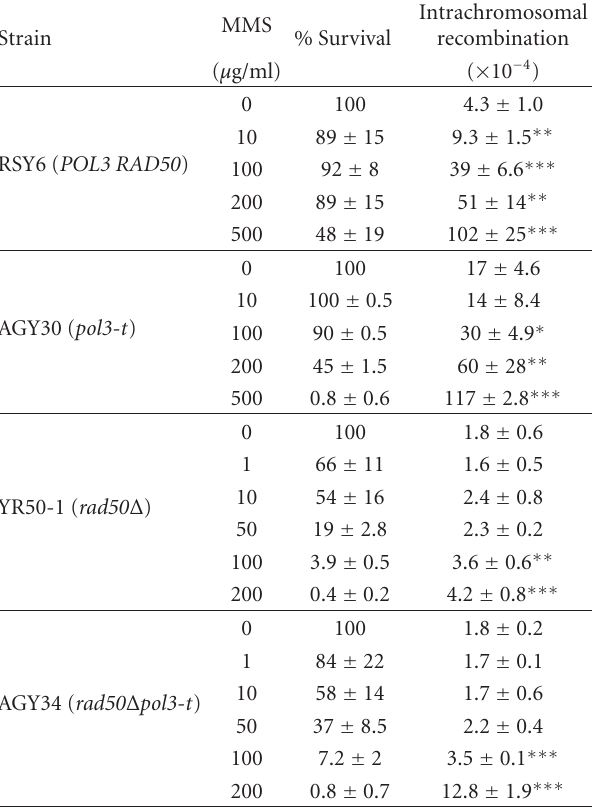
Table 4: E ff ect of pol3-t on MMS-induced intrachromosomal recombination in RAD + and rad 50 Δ strains. Data corresponding to RSY6 and AGY30 were previously published [14]. Results are reported as the mean of five or more independent experiments ± standard deviation. All strains are isogenic. The probabilities refer to the comparison between the exposure and the untreated